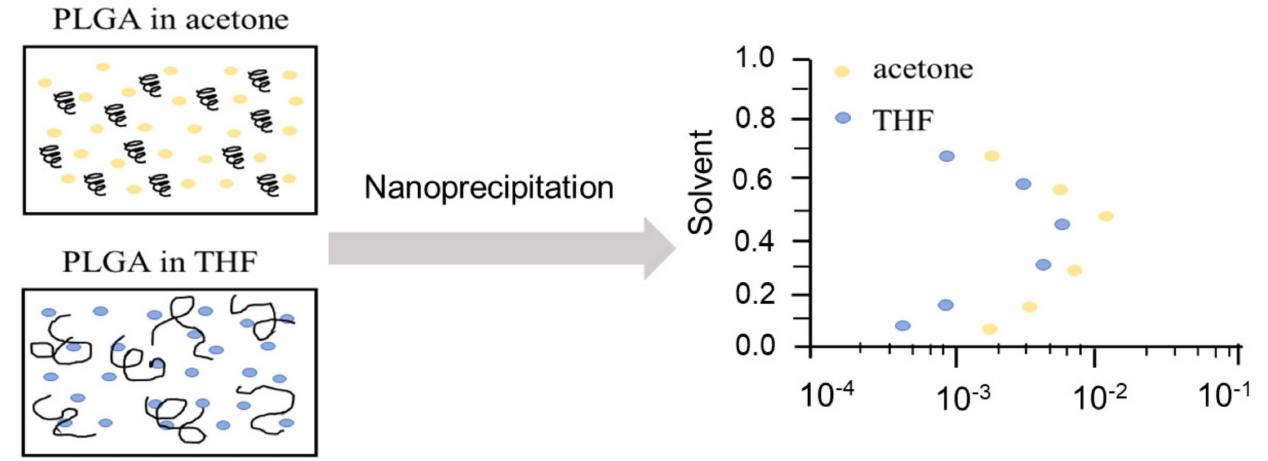
Figure 6. “Ouzo” region of PLGA in two different solvents (adapted from Beck-Broichsitter et al., 2016